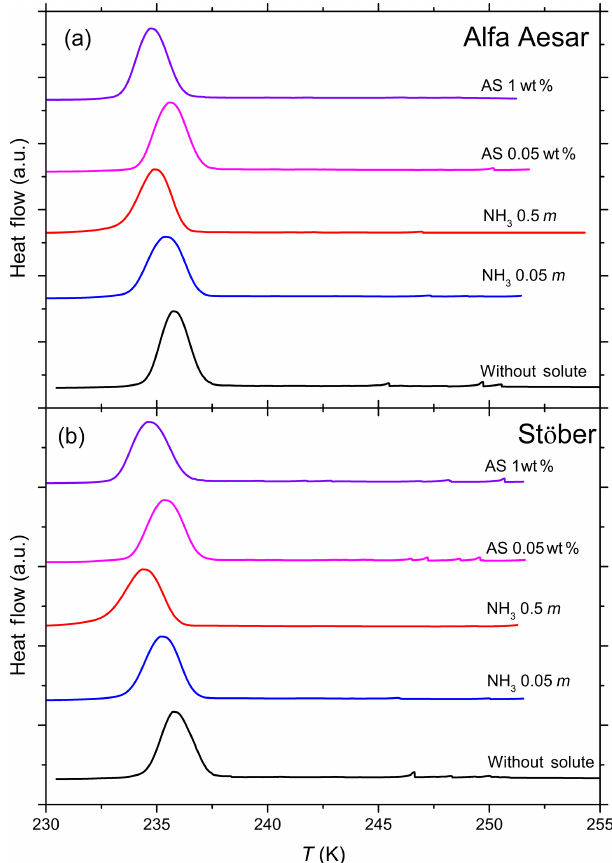
Figure 4. DSC thermograms of 10wt% Alfa Aesar (a) and 10wt% Stöber (b) silica particles suspended in pure water, ammonia (NH 3 ; 0.05 and 0.5molal) and ammonium sulfate (AS; 0.05wt% and 1wt%) solution droplets of varying concentrations (corresponding to a w range of 1–0.987). All curves are normalized such that the ar- eas under the heterogeneous and homogeneous freezing curves sum up to the same value. DSC thermograms of both amorphous silica samples show only one clear freezing signal that is indistinguishable from the homogeneous freezing signal. T hom of the corresponding emulsion freezing experiments with the pure solutions (in the ab- sence of the silica particles) has been taken as the dividing temper- ature of heterogeneous and homogeneous freezing to evaluate F het (Table 2; see Sect.